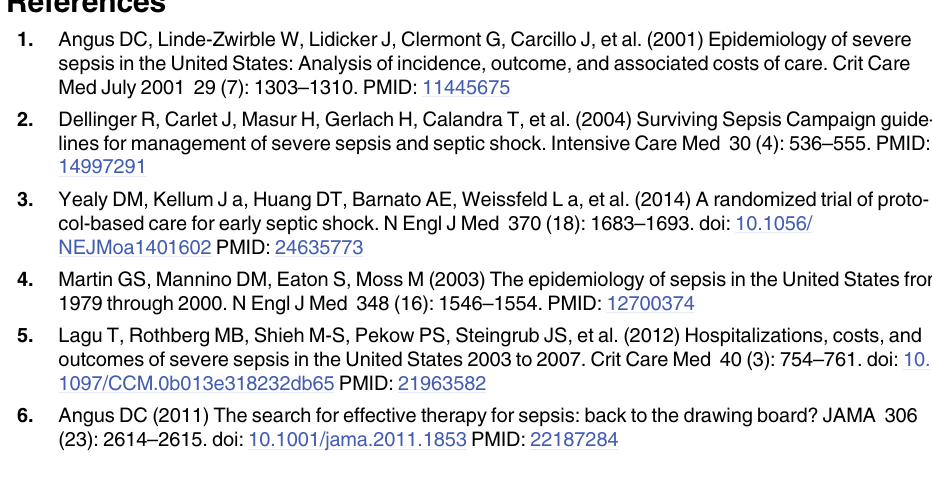
S2 Fig. Effects of varying Nk decay rates on simulated treatment. Survival rates of a simu- lated population of animals following treatment with the proposed extracorporeal device con- sidering a device-receptor affinity of 1x10-3 M for k_Nk values of (A) 50% above, (B) 10% above, (D) 10% below, and (E) 50% below the baseline vale (C) . In all cases the time of treat- ment was varied between 0 and 10 hours post infection and ended between 0 and 100 hours post infection. (TIF) S3 Fig. Effects of varying Nk induction rates on simulated treatment. Survival rates of a sim- ulated population of animals following treatment with the proposed extracorporeal device con- sidering a device-receptor affinity of 1x10-3 M for k_Nk_IL8 values of (A) 50% above, (B) 10% above, (D) 10% below, and (E) 50% below the baseline estimated value (C) . In all cases the time of treatment was varied between 0 and 10 hours post infection and ended between 0 and 100 hours post infection. (TIF) S1 Dataset. Experimental data. Sixteen baboons ( Papio ursinus ) weighing between 19 and 32 kg were infused with 2 x 109 CFU Escherichia coli per kg over a two-hour period and followed until predetermined time points or death.